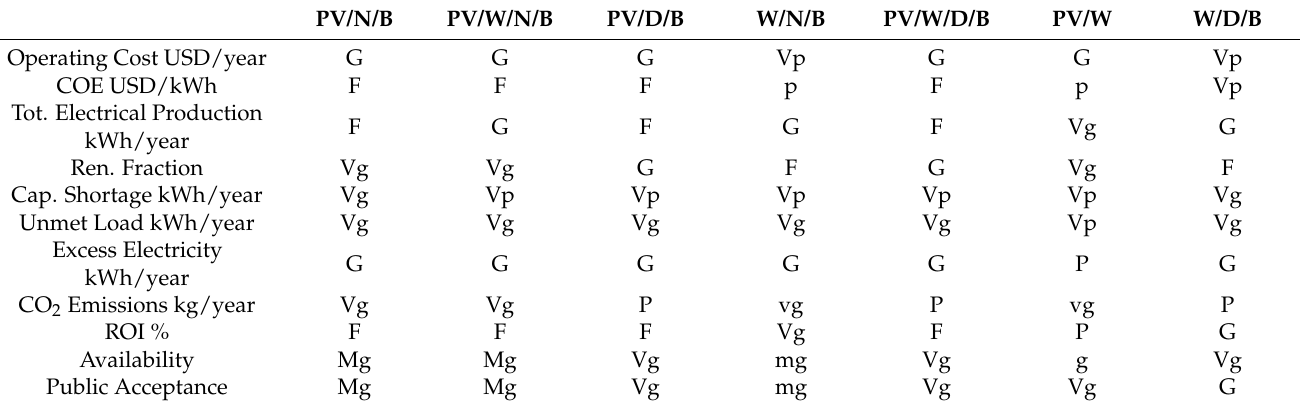
Table 5. Decision matrix using output from HOMER software.